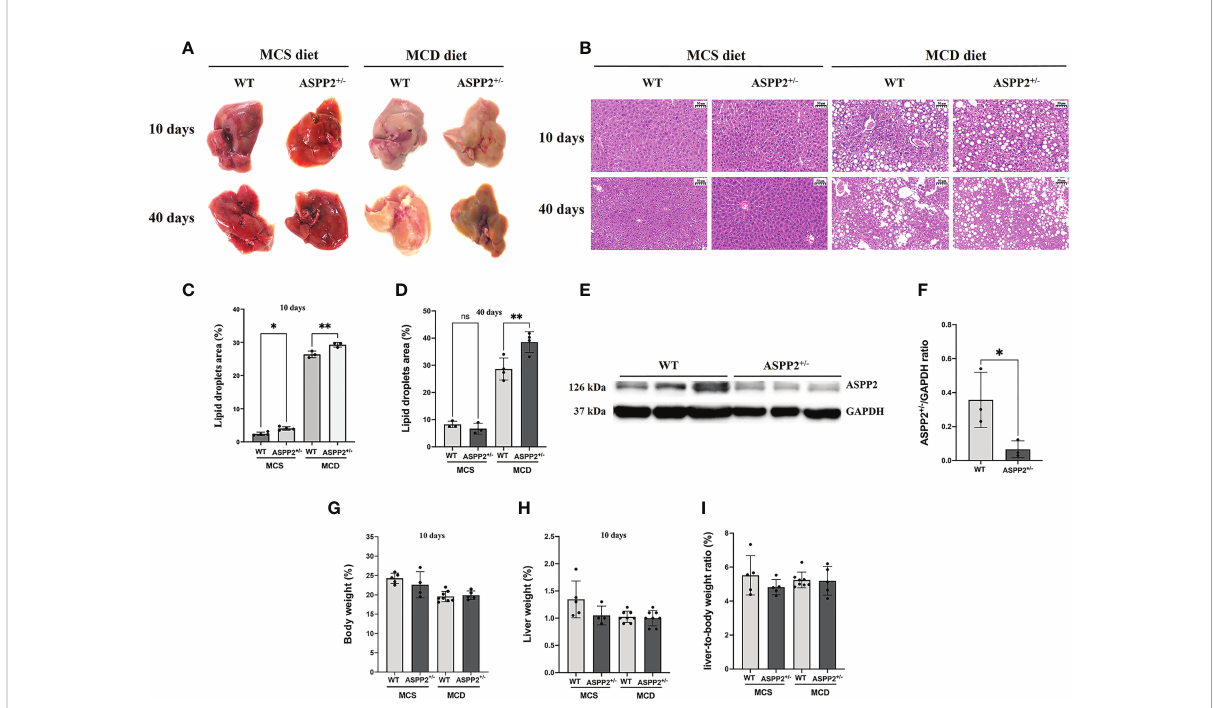
FIGURE 1 ASPP2 de fi ciency increased MCD and MCS diet-induced hepatic steatosis. (A) Representative macroscopic images of the livers of WT and ASPP2 +/- mice induced by MCD or MCS diet. (B) H&E staining of liver sections of WT and ASPP +/- mice. Quanti fi cation of the mean area of lipid droplets at days 10 (C) and 40 (D) in WT and ASPP2 +/- mice groups. (E, F) The expression of ASPP2 protein in the liver of WT and ASPP2 +/- mice. The liver weight (G) , body weight (H) , the liver-to-body weight ratio (%) (I) in WT and ASPP2 +/- mice at 10 days induced by MCD and MCS diet. WT-MCS group, n =3-5; ASPP2 +/ – MCS group, n =3-4; WT-MCD group, n =3-8; ASPP2 +/- -MCD group, n =3-8. *p < 0.05; **p < 0.01. ns, no signi fi